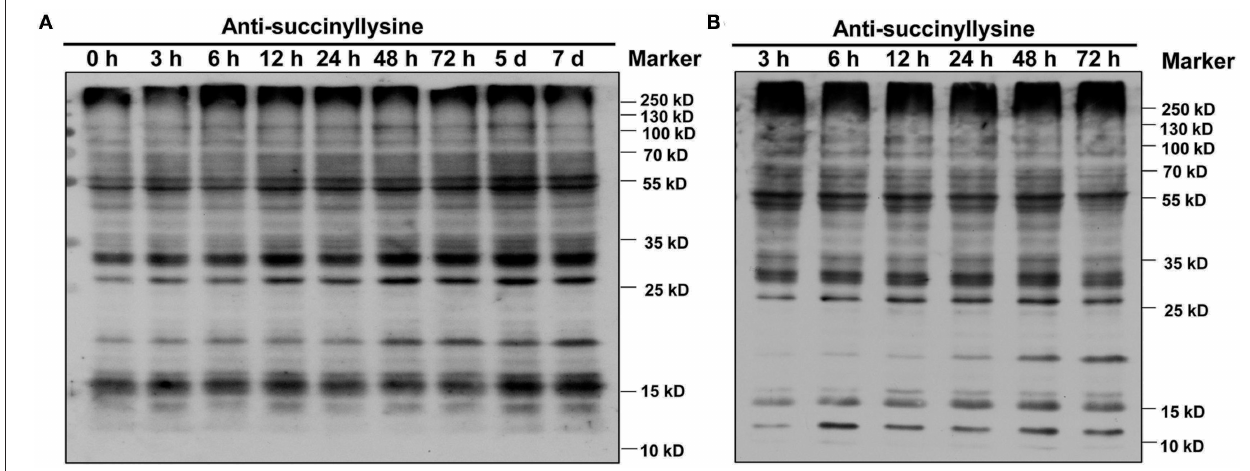
FIGURE 2 | Dynamics of protein succinylation in roots of GN121 seedlings under Pi starvation and recovery using the anti-suc-lysine antibody. For immunoblot results, proteins were collected from (A) low-Pi (0.039mM Pi) at 0, 3, 6, 12, 24, 48, 72h, 5 d, and 7 d, and (B) Pi recovery (0.39mM Pi) at 3, 6, 12, 24, 48, and 72h. The same amount of protein (25 µ g per lane) was loaded in each panel.